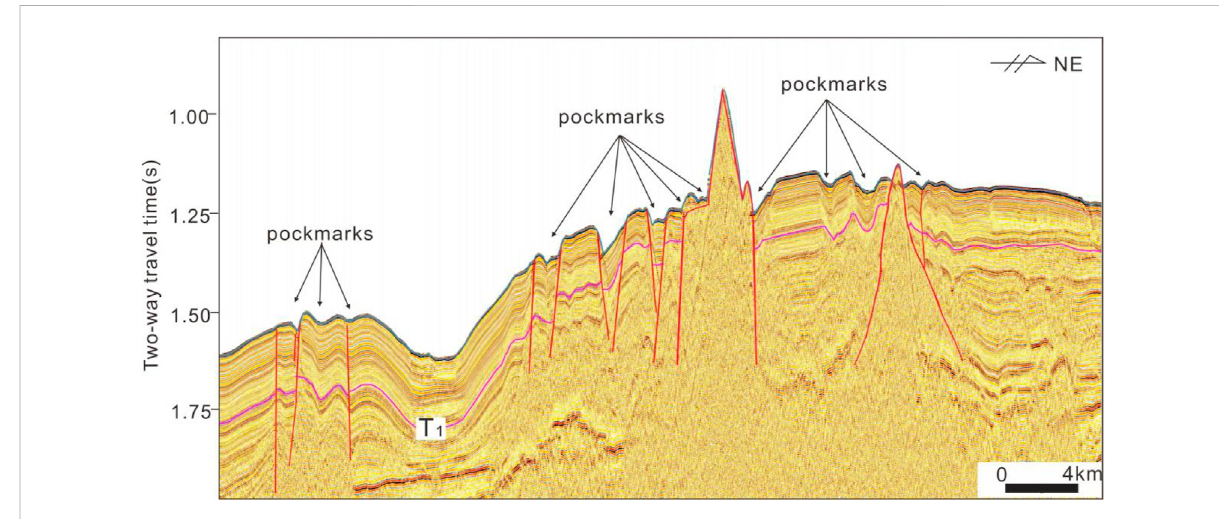
FIGURE 11 Active faults and Markeng recorded by single seismic pro fi